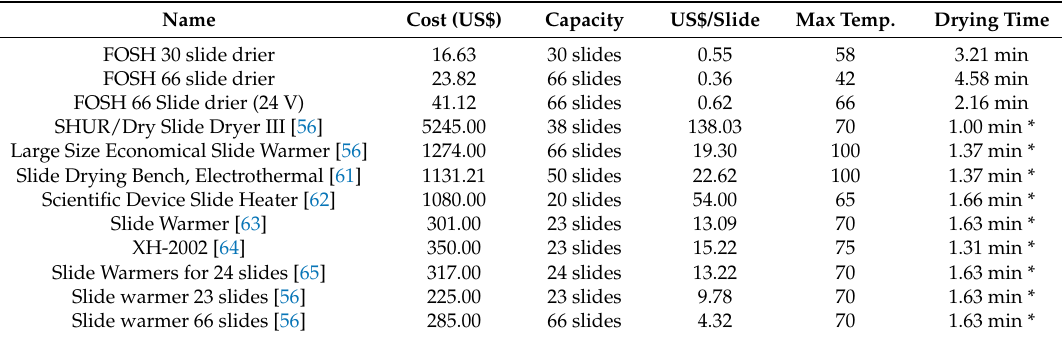
Table 2. A comparison of commercial slide driers and the FOSH solution. Times denoted with * indicate experiment-based predictions based on maximum device temperature and not actual measurements from the